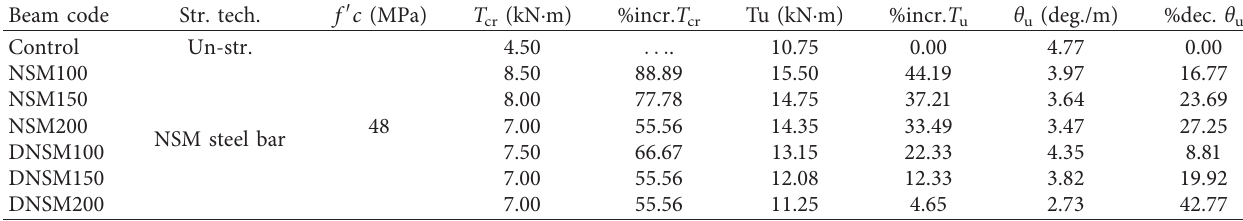
Table 3: Experimental results of the tested beams.